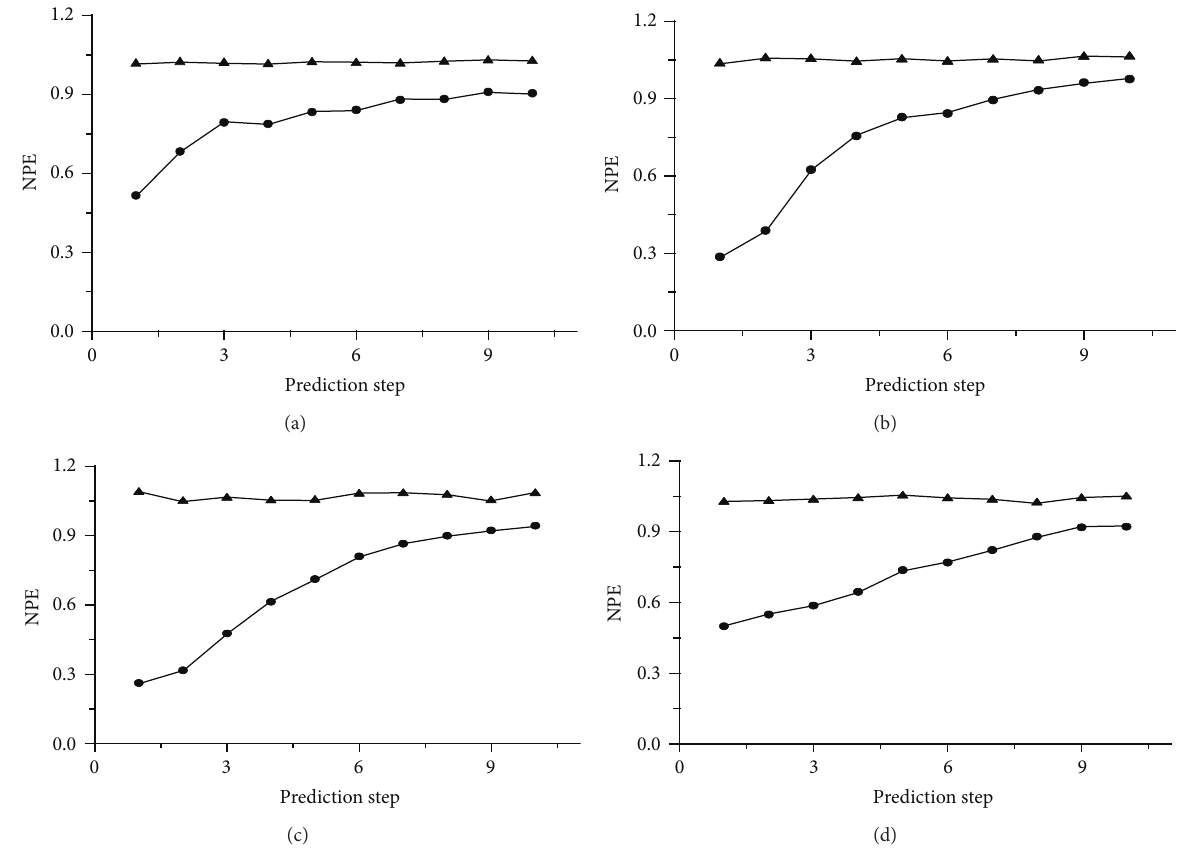
Figure 9: NPE of the experimental chaotic firings. (a) The chaotic bursting between period-1 and period-2 burstings of example 1 (Figure 5(a)). (b) The chaotic bursting lying between period-2 and period-3 burstings of example 2 (Figure 7(b)). (c) The chaotic spiking of example 2 (Figure 7(c)). (d) The chaotic bursting lying between period-1 and period-2 burstings of example 3 (Figure 8(b)). Lines with squares show the original chaotic firing pattern and lines with triangles show the surrogate